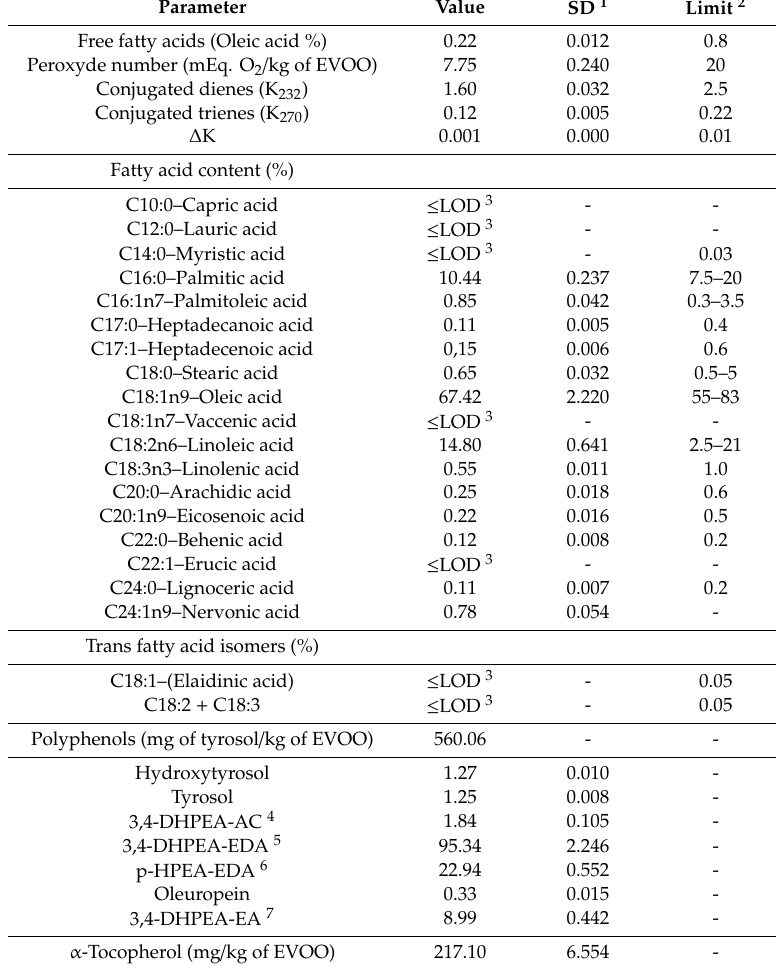
Table 1. Baseline parameters (T 0 ) of extra virgin olive oil before bottling with or without a nitrogen